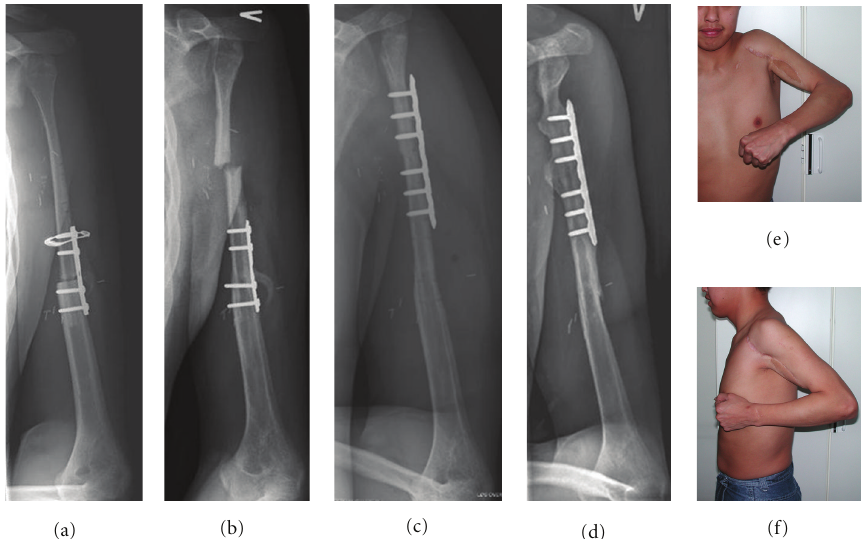
Figure 5: Resection of the proximal part of the humerus because of an osteosarcoma and reconstruction with a vascularized fibula graft including the proximal epiphysis (patient 5). X-rays taken 1 month postoperatively (a), and after 8 months when the junction was healed but the patient had just sustained a fracture of the graft (b) treated by plate ostesynthesis (c). 29 months after insertion of the graft, where the patient has had one more fracture just above the plate healed on conservative treatment; X-ray (d) and clinical photos showing active abduction (e) and extension (f) of the shoulder joint just before removal of the